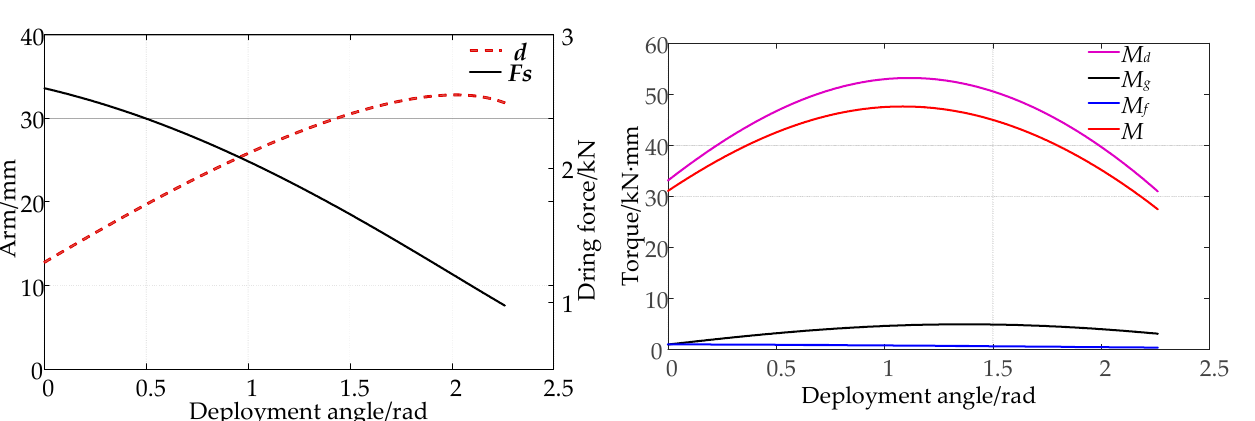
Figure 4. The relationship between driving force, arm, torque and deployment angle. Formula (1) is a second-order nonlinear differential equation of the deployment time t . Among them, the prescribed position θ p ( t e ) is equal to 129.5 ◦ , and both the initial deployment angle θ ( t 0 ) and the initial deployment angular velocity ω ( t 0 ) are equal to zero. According to the numerical method of Runge—Kuta, the high-precision ODE 45 can be employed to solve the theoretical model of deployable mechanism. As shown in Figure 9, the relationships between deployment angle, deployment angular velocity and deployment time are obtained.